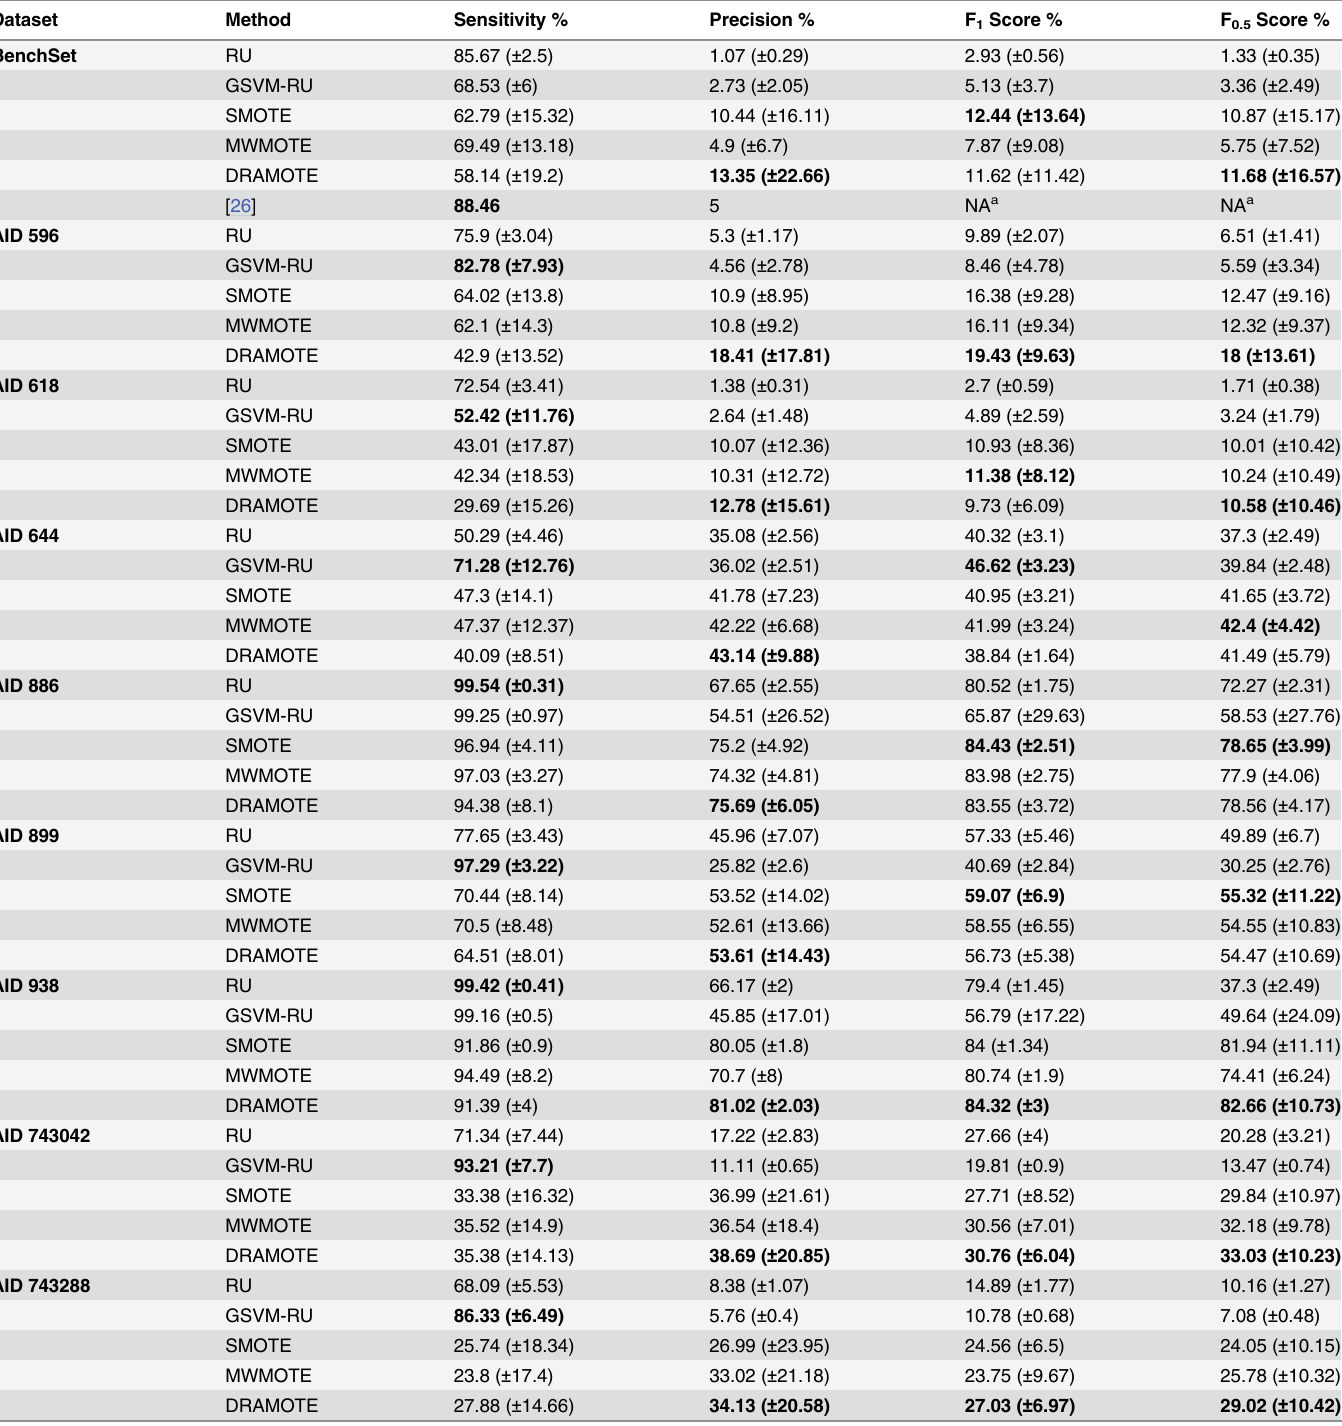
Table 2. Comparison of the data preprocessing methods. Larger standard deviation values are the result of averaging over different types of classifiers in this summary table.